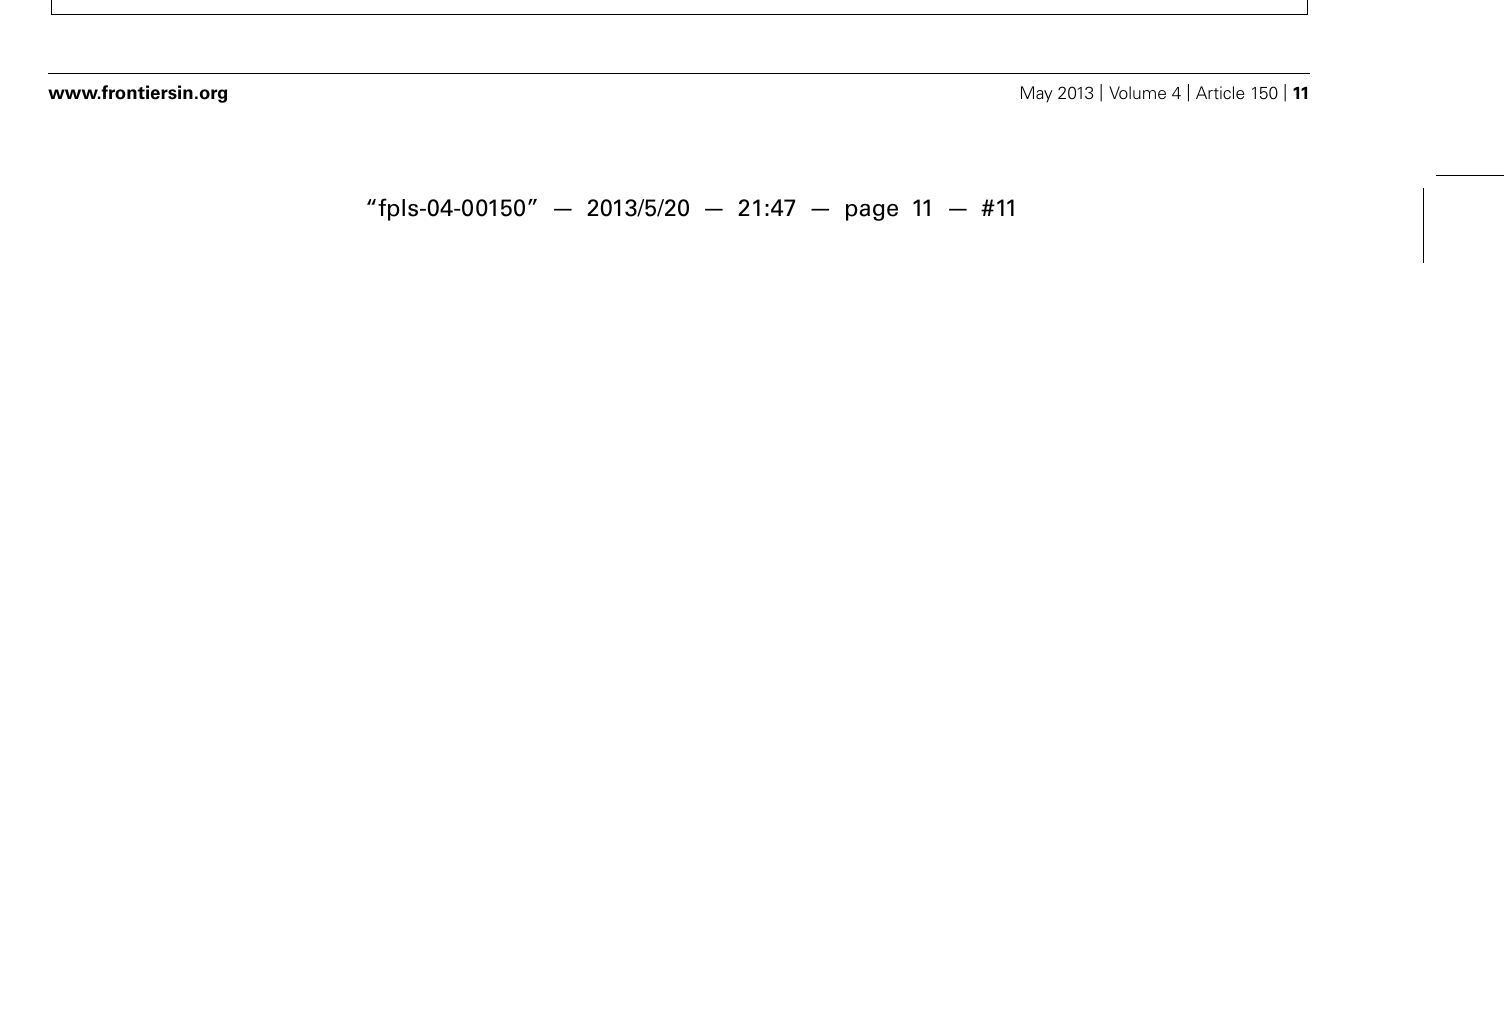
FIGURE 6 | Malate dismutation and energy metabolism in anaerobic mitochondria. The map is redrawn based on the review of Müller etal. (2012).The main end products are acetate and propionate, with minor